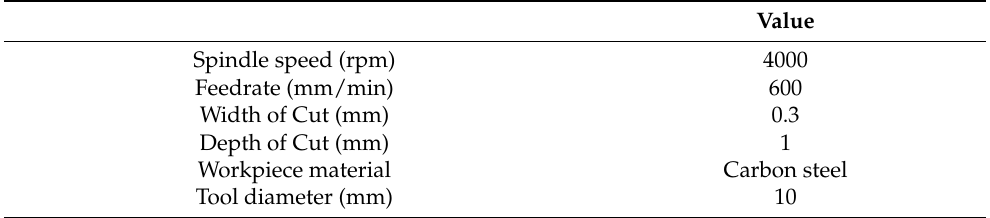
Table 7. Cutting parameters for experiment 4.